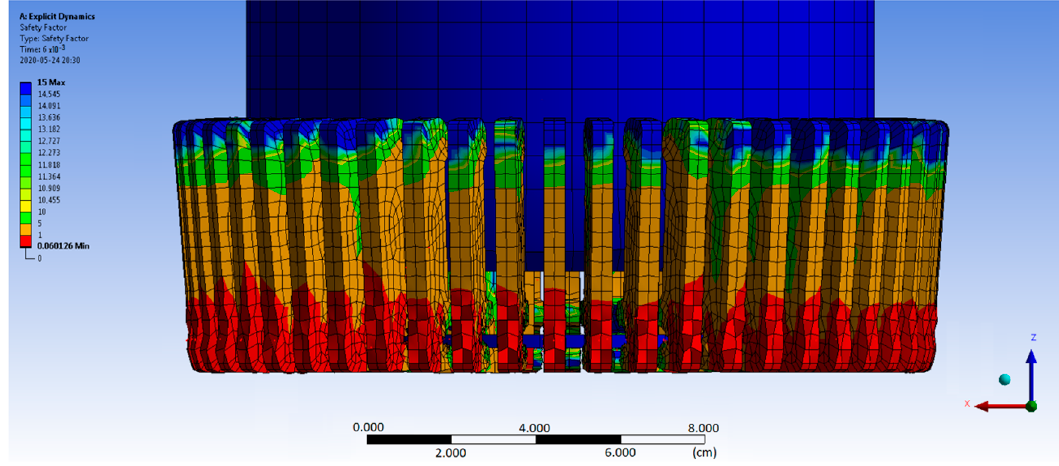
Figure 12. View showing the hourglass effect.